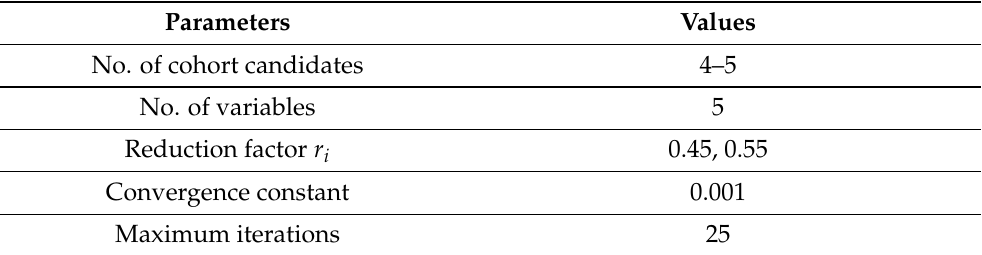
Table 2. CI algorithm specifications.